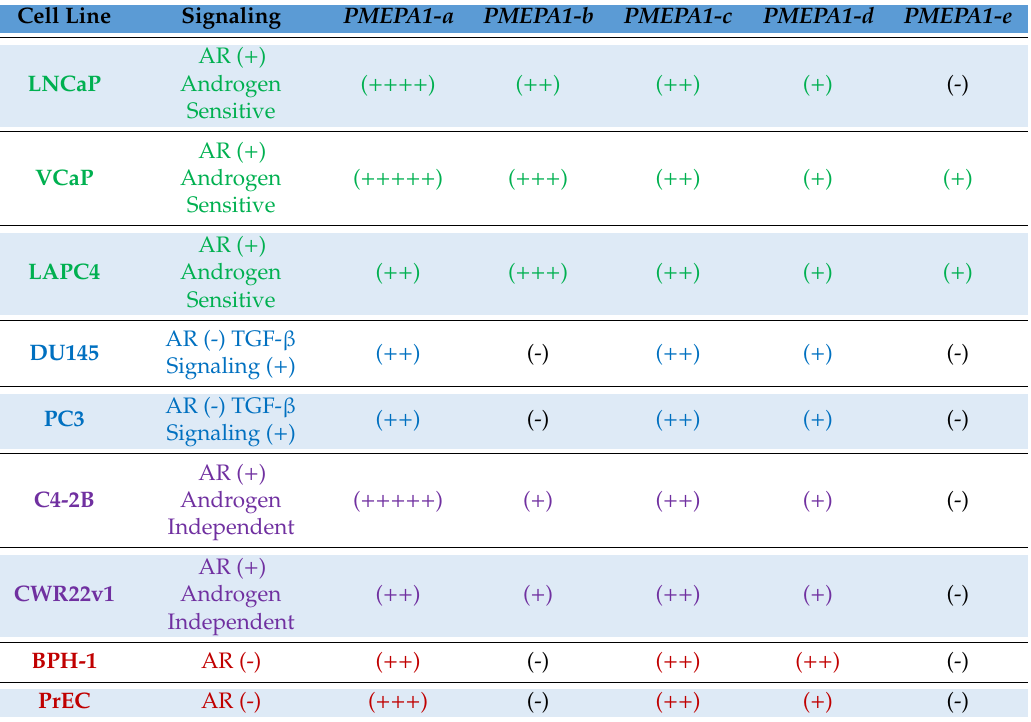
The color code represents: green: AR-positive (androgen sensitive); blue: AR-negative and TGF- β -signaling-positive; purple: AR-positive (androgen independent): and red: AR-negative. The numbers of ( + ) represents the relative transcript levels of PMEPA1 isoforms in